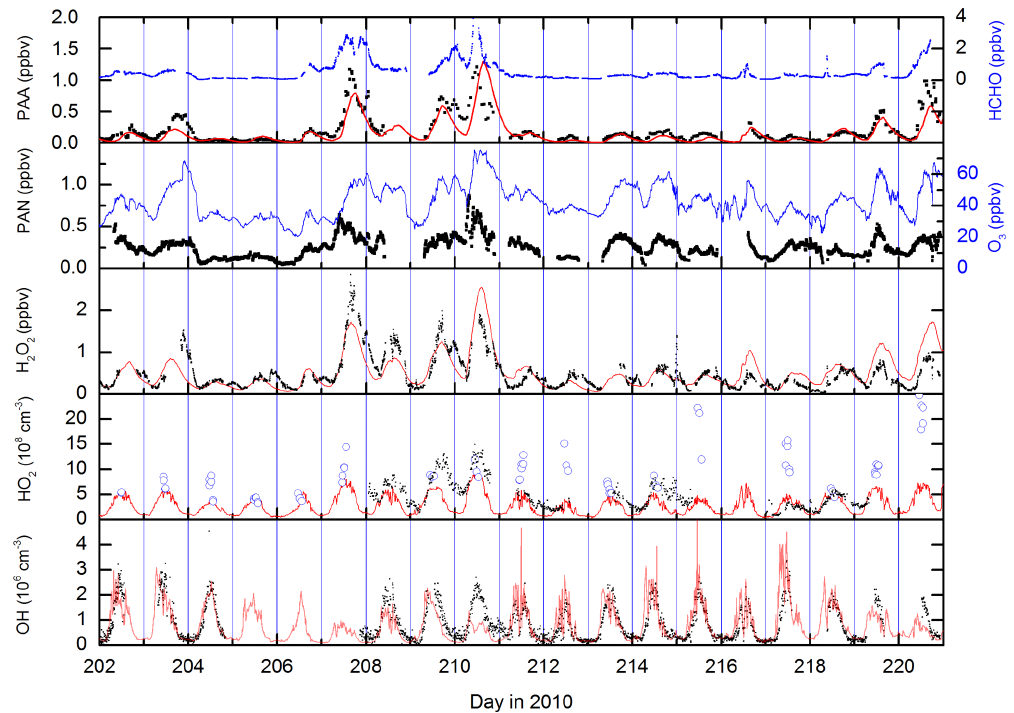
Figure 7. Measurements (black and blue data points) and model (red lines). The OH data set displayed is from CIMS measurements at ground level and has been adjusted to match levels observed at canopy height (see supplementary information and Hens et al., 2014). The open violet circles are HO 2 concentrations calculated from the PAN-to-PAA ratio and the steady-state expression (Eq. 4) presented in Sect.